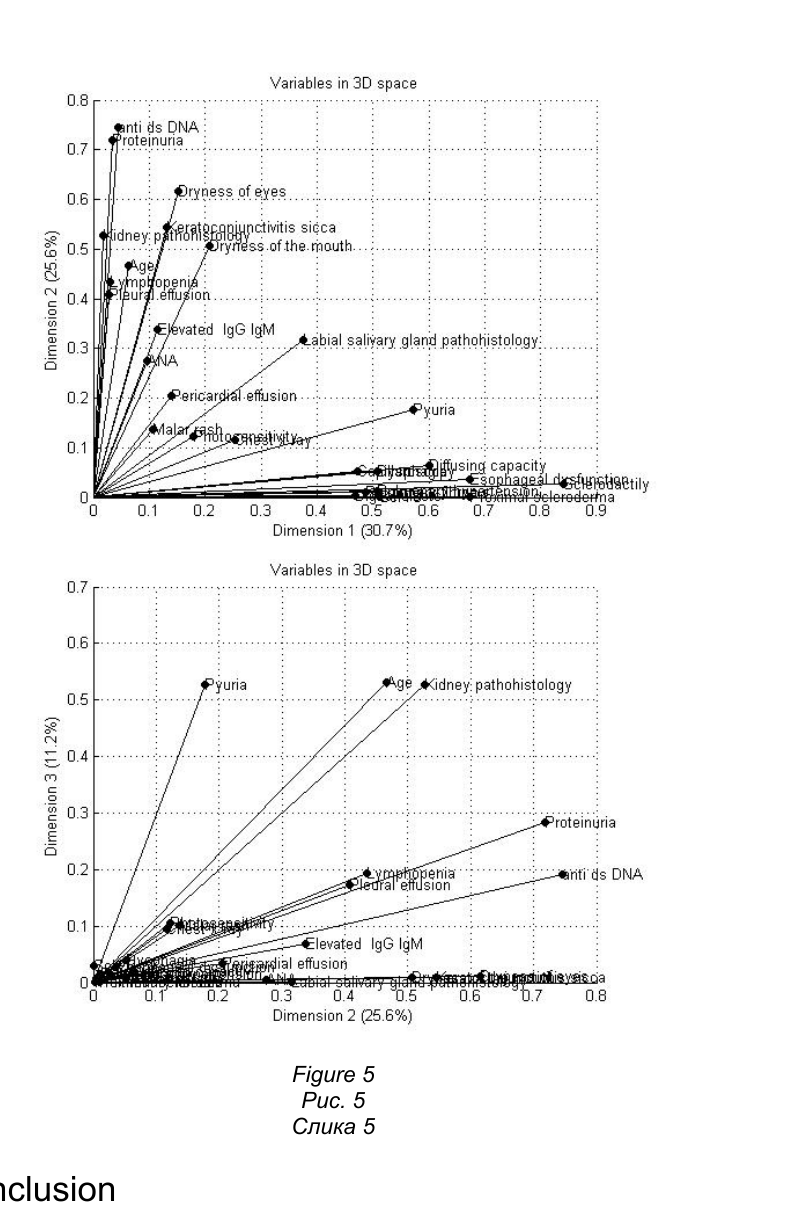
Figure 5 Рис . 5 Слика